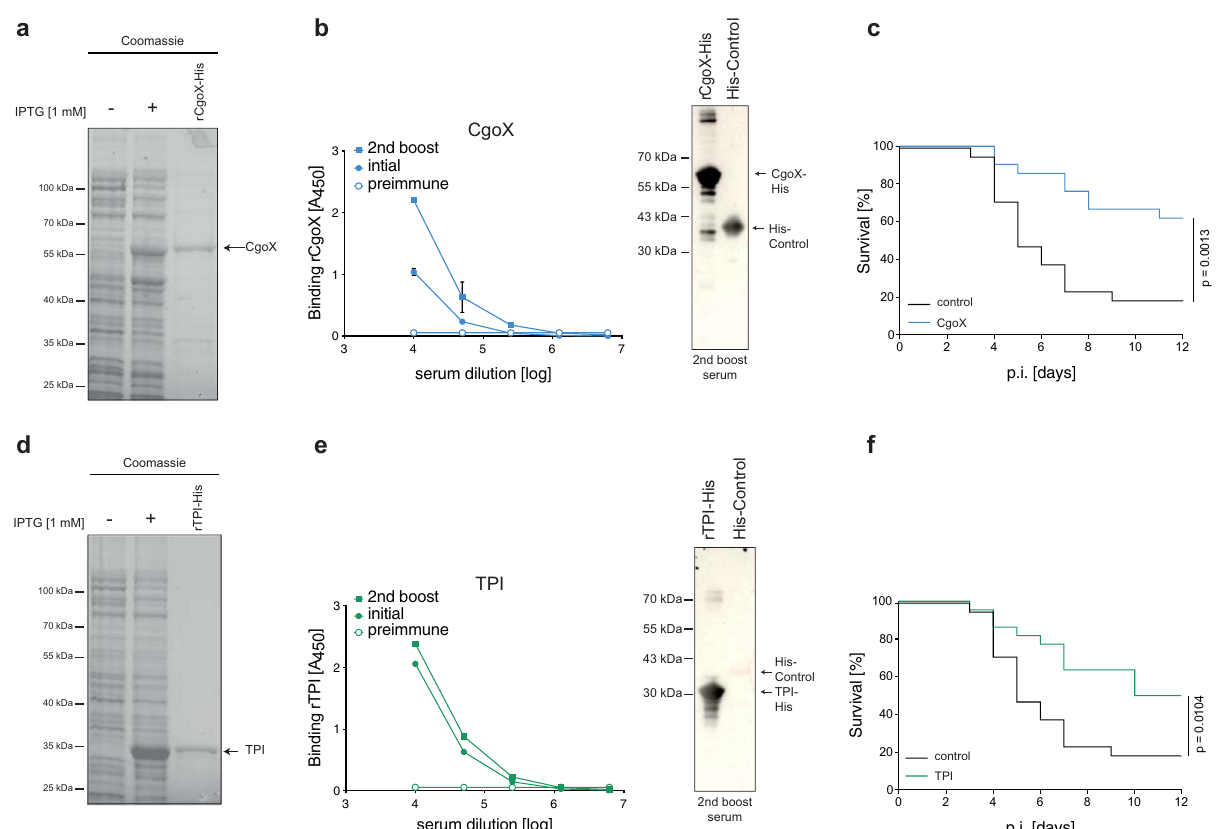
Fig. 1 Active immunisation with S. aureus vaccine candidates. a SDS-PAGE analysis of coomassie stained E. coli lysate and puri fi ed rHis 6 - tagged CgoX protein (56 kDa) expressed in E. coli BL21(DE3). DE3 cells were left untreated ( − ) or induced with IPTG ( + ) for expression. b Left panel: antigen-speci fi c IgG response of immunised BALB/c mice. Sera of mice ( n = 12) immunised with S. aureus rCgoX formulated with Freund ’ s adjuvant (FA) were collected and pooled at day 0 (preimmune), 14 (initial) and 66 (2nd boost) after initial immunisation and analysed by ELISA for IgG binding to rCgoX-His ( n = 2). Data are presented as mean ± s.d. Right panel: antigen-speci fi city of sera from immunised mice was analysed by WB. Sera collected and pooled at day 66 after initial immunisation with rCgoX-His were analysed for binding to rCgoX-His or His-tagged S. aureus rPephyd protein (39 kDa) used as control. Bound murine IgG were detected with anti-mIgG-HRP. c Survival of immunised mice after challenge with S. aureus ( n = 11 for control, n = 12 for CgoX). BALB/c mice were immunised with rCgoX-His/FA and challenged i.v. with 3 × 10 7 S. aureus strain ATCC 29213. Control mice were immunised with BSA/FA. Signi fi cance was calculated by Log-rank (Mantel-Cox) test. d SDS-PAGE analysis of coomassie stained E. coli lysate and puri fi ed His 6 -tagged TPI protein (32 kDa) expressed in E. coli BL21(DE3). DE3 cells were left untreated ( − ) or induced ( + ) with IPTG for expression. e BALB/c mice ( n = 12) were immunised with S. aureus antigen rTPI-His/FA and serum pools were analysed by ELISA for IgG binding to rTPI-His ( n = 2). Data are presented as mean ± s.d. Right panel: Sera collected and pooled at day 66 after initial immunisation with rTPI-His were analysed by WB for binding to rTPI-His and rPephyd-His (39 kDa) used as control. Bound murine IgG were detected with anti-mIgG-HRP. f Survival of mice immunised with rTPI-His formulated with FA ( n = 11) or BSA / FA ( n = 12) and challenged i.v. with 3 × 10 7 S. aureus strain ATCC 29213. Signi fi cance was calculated by Log-rank (Mantel-Cox)